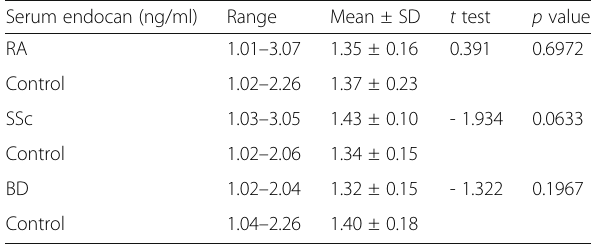
Table 2 Serum endocan level in RA, SSc, BD, and control groups